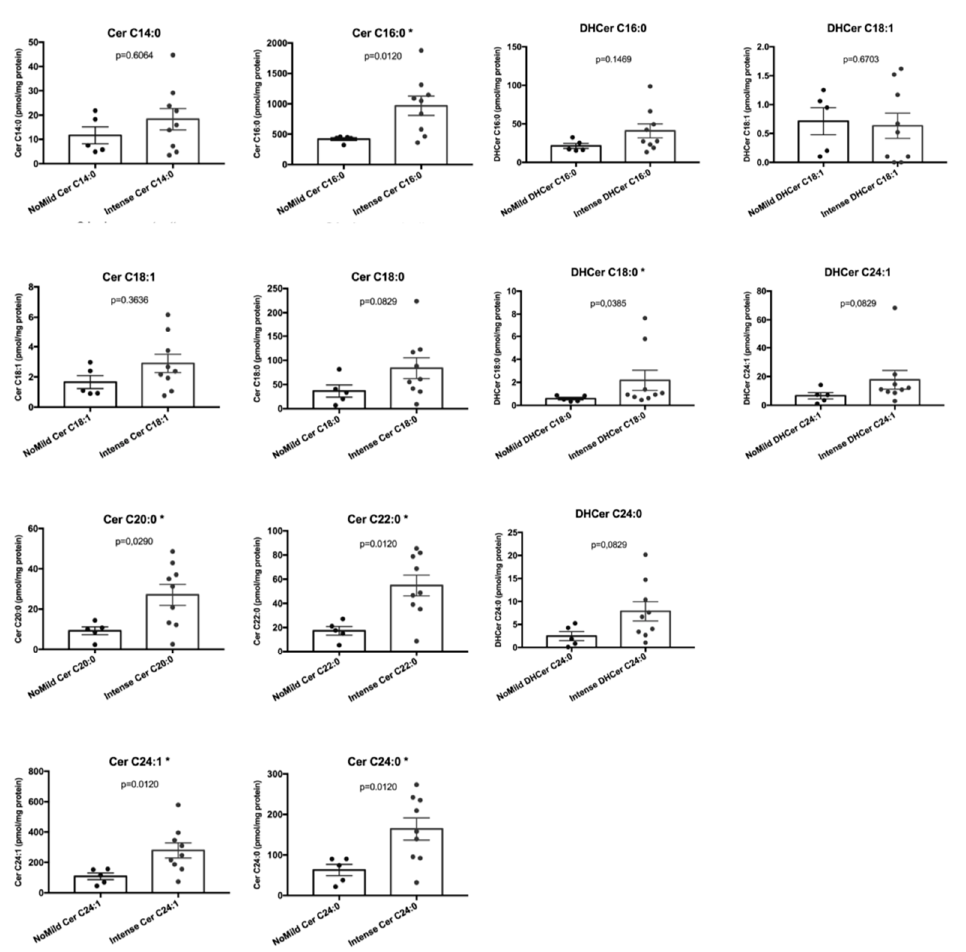
Figure 5. Bar graphs, with SEM, showing the content of single ceramides and dihydroceramides species according to MR contrast enhancement (no/mild and intense contrast enhancement chordoma groups). *, p ≤ 0.05.